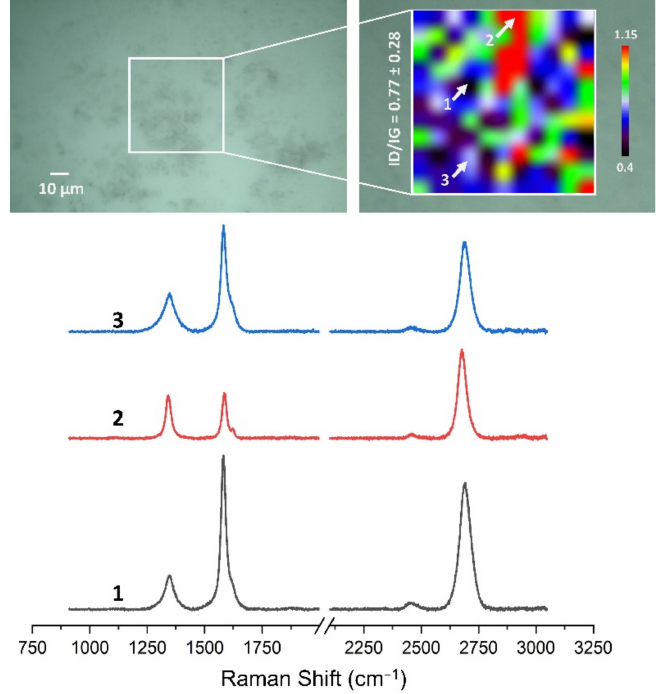
Figure 15. The Raman map and spectra of HSMG ® graphene transferred onto Al 2 O 3 ceramic substrates etched with 5% HF acid.